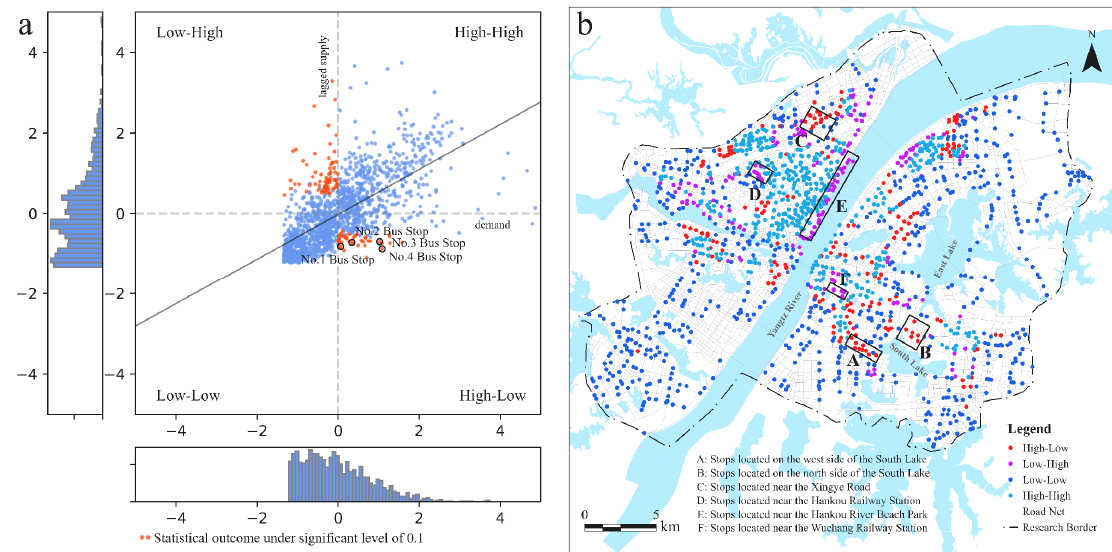
Figure 4. Moran scatterplot and corresponding classification results of bus stops. ( a ) Moran scatterplot of the jobs-housing activity distribution and bus services distribution; ( b ) Classification results of bus stops based on the Moran scatterplot.